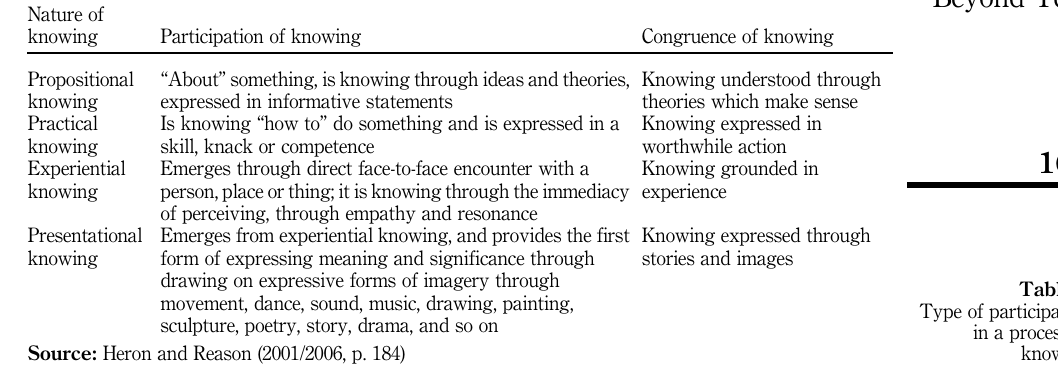
Table I. Type of